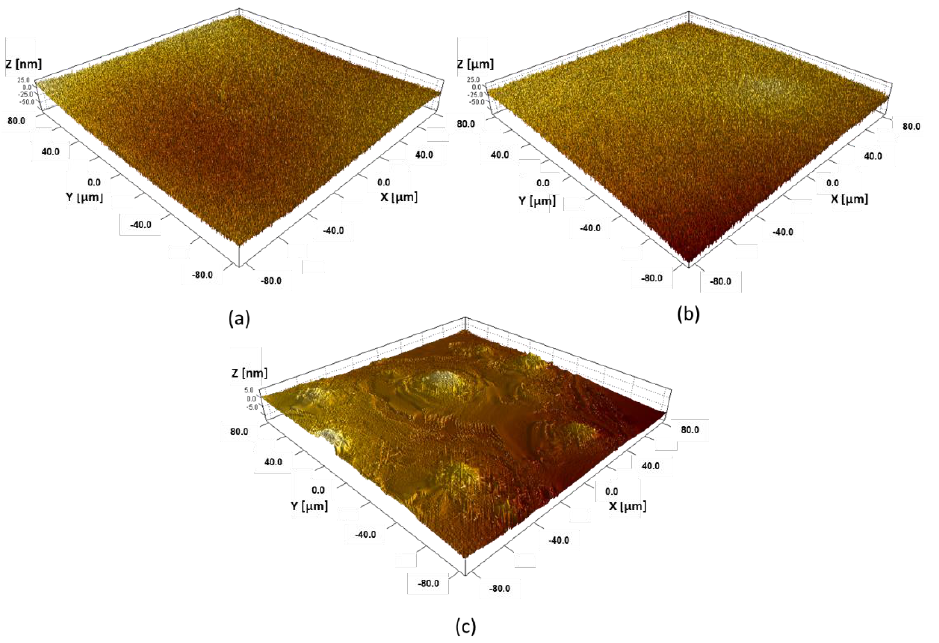
Figure 3. 3D profilometer images of glass ( a ), epoxy resin ( b ), and GNP composite ( c ).